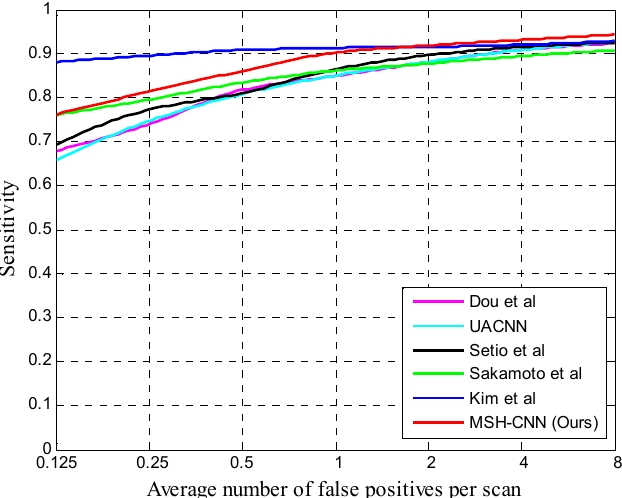
Figure 4. The free receiver operation characteristic (FROC) curves of different methods.